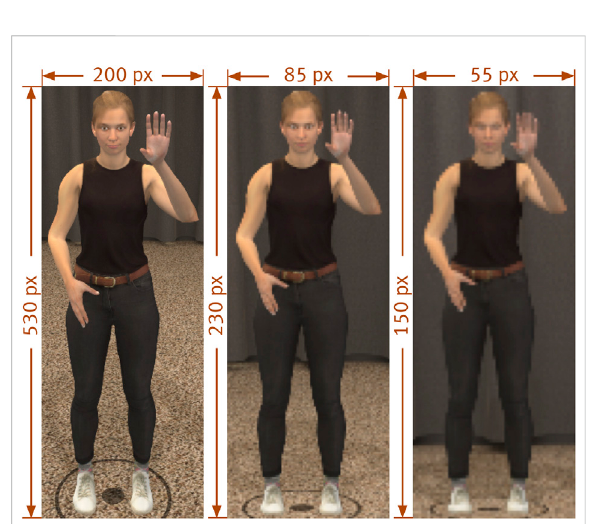
FIGURE 2 Enlargements of the yellow outlined areas in Figure 1 following the same order. They illustrate the effects of reducing the relative size of the avatar in the user ’ s entire fi eld of view by increasingtheSOD.Theresultingresolutionsareplottednext to the